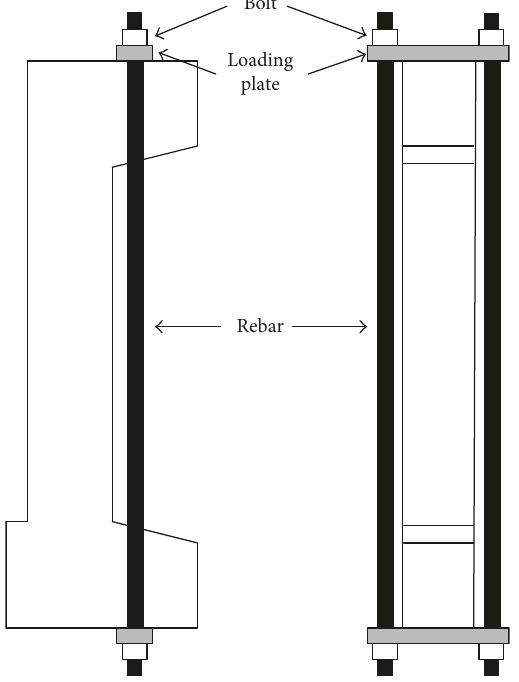
Figure 3: Setup for applying persistent compressive load.